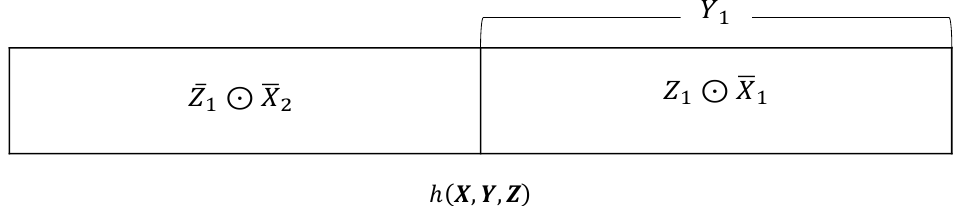
Fig. 11. Map representation of a function ℎ(𝑿, 𝒀, 𝒁) whose assertion is equivalent to equality of 𝑠 and 𝑡 in